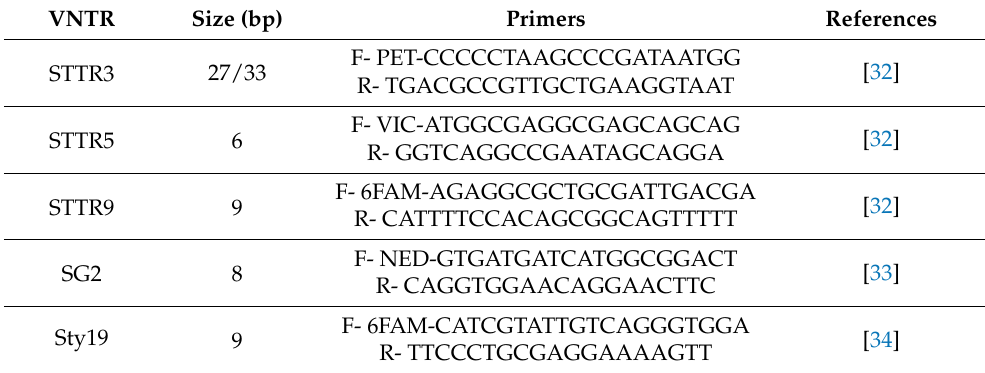
Table 6. Selected primers for the amplification of